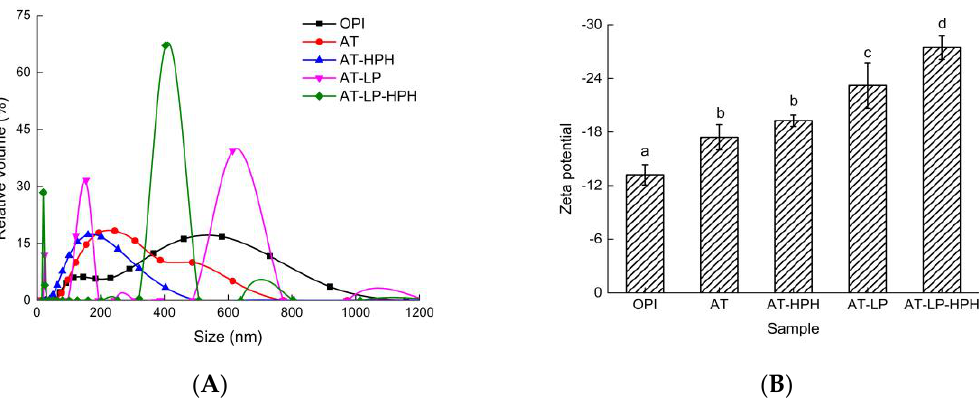
Figure 3. Particle size distribution ( A ) and zeta potential ( B ) of OPI and the modified samples. Different letters represent significant differences at p < 0.05.